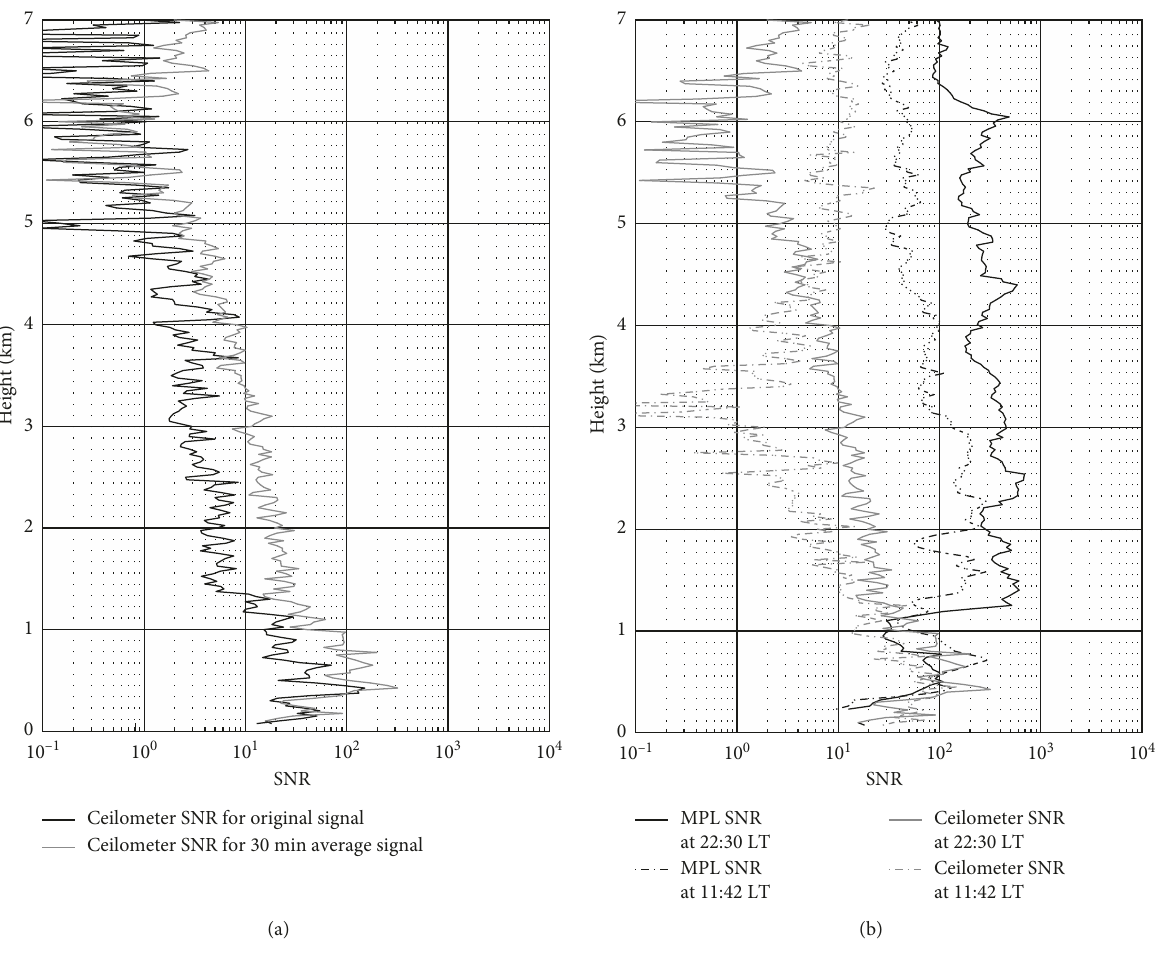
Figure 1: The SNR for the CYY-2B ceilometer and the MPL as a function of